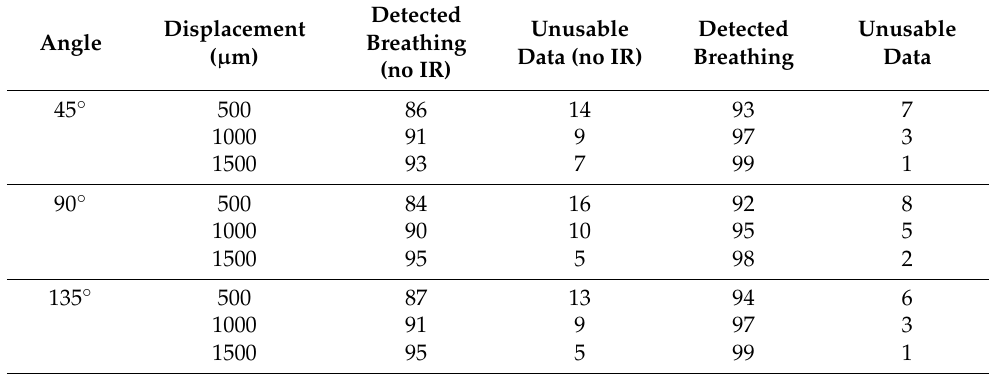
Table 2. Mechatronic breathing simulations: accelerometer detection versus multisensory detection.